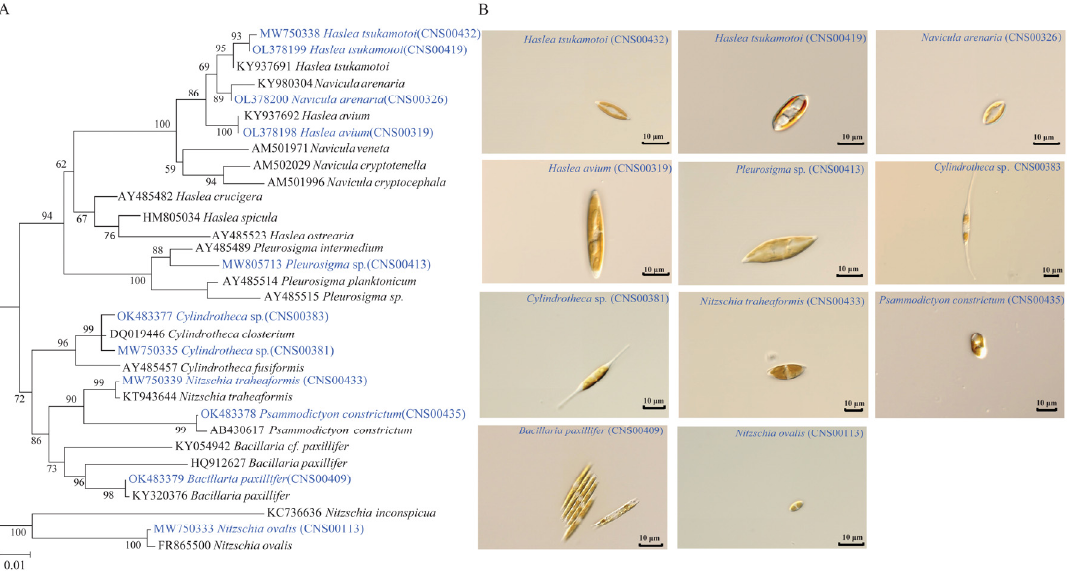
Figure 2. Morphological and molecular analysis of diatom species analyzed in this study. ( A ) Phylogenetic analysis based on 18S ribosomal DNA (18S rDNA) gene. Numbers at the branches represent bootstrap values. Branch lengths are proportional to the genetic distances, which are indicated by the scale bar. ( B ) Representative micrographs of 11 diatom species studied in this project. Bar = 10 μ m.